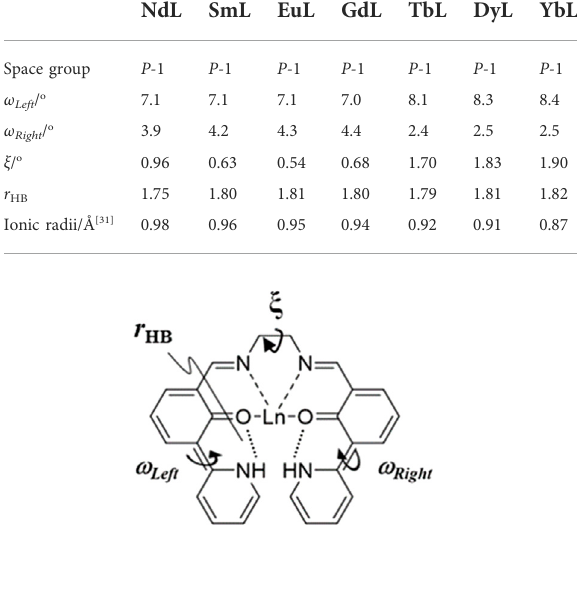
TABLE1ComparisonofdihedralanglesandionicradiiofLnL(Ln=Nd, Sm, Eu, Gd, Tb, Dy, and Yb). ω Left and ω Right are dihedral angles of aromatic rings crosslinked at C (6) – C (5) and C (21) – C (22), respectively. The ξ value is the dihedral angle between the two π - electronic systems. r HB isthe averagevalue oftwo hydrogen bond